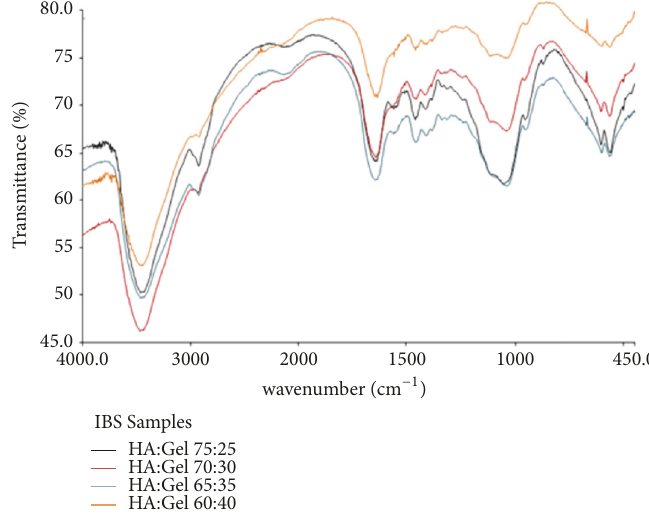
Figure 1: The FTIR result of IBS sample with several ratios of